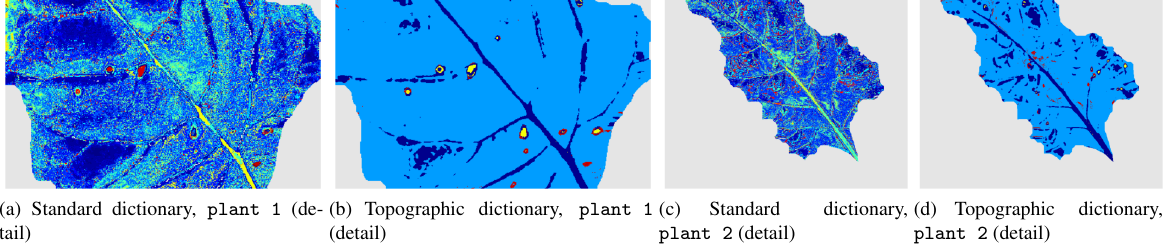
Figure 5: Detailed illustration of reconstruction error obtained by sparse representation with topographic and standard dictionary (i.e. , no group sparsity). Blue color indicate a low value and yellow colors a high value.